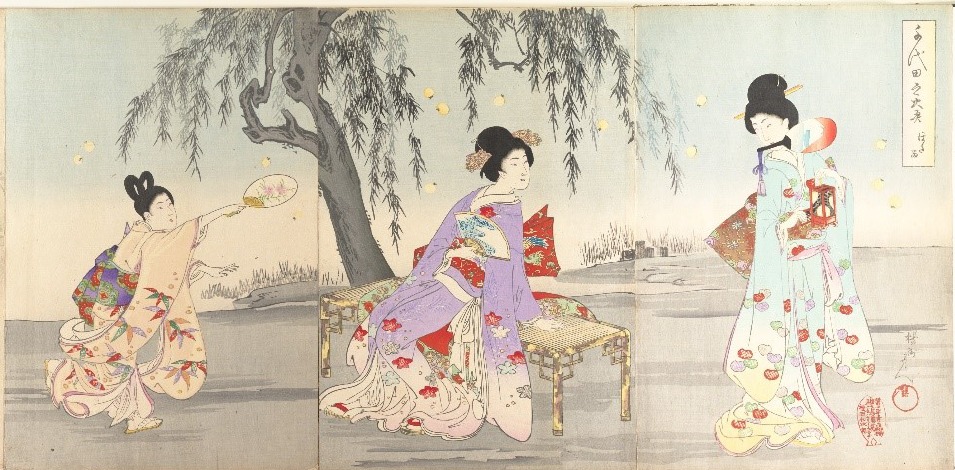
Figure 4. (T12). Chiyoda Castle (Album of Women). 1895. Yōshū (Hashimoto) Chikanobu (Japanese, 1838–1912). Triptych of woodblock prints; ink and color on paper. Gift of Mrs. W. Walton